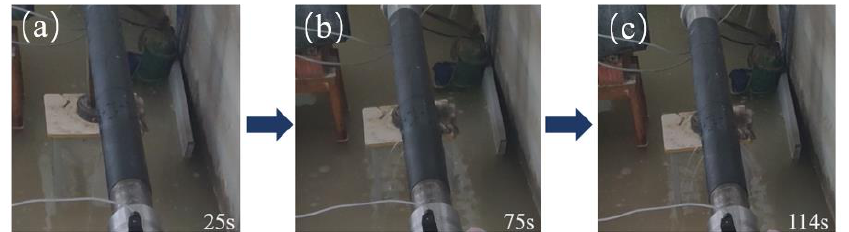
Figure 15. Experimental phenomena of experiment I: ( a ) Experimental phenomenon at 25 s; ( b ) Experimental phenomenon at 75 s; ( c ) Experimental phenomenon at 114 s.